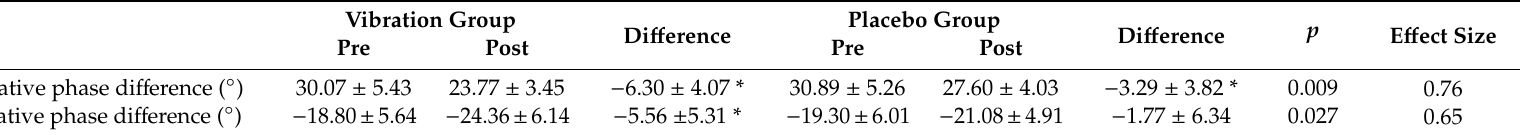
Table 4. Subject scores of Lumbar-hip coordination during STS before and after